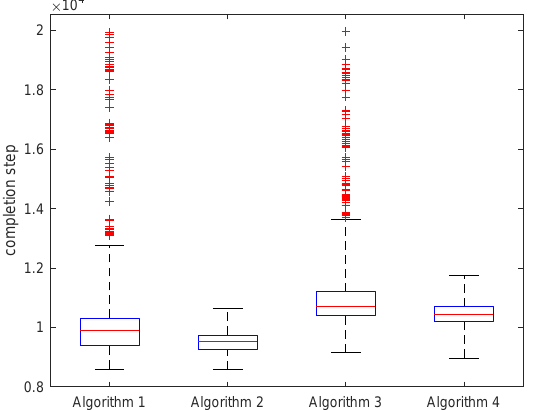
Figure 11. The completion step of Algorithms